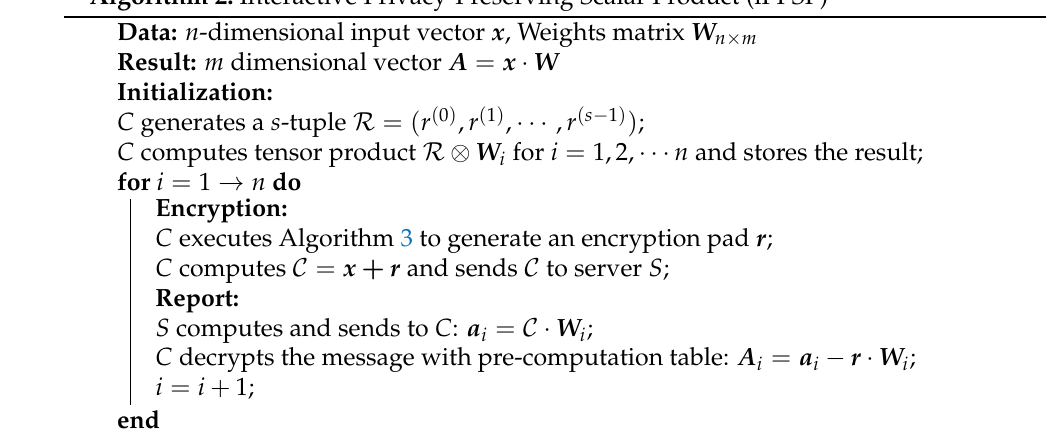
Algorithm 2: Interactive Privacy-Preserving Scalar Product (iPPSP)